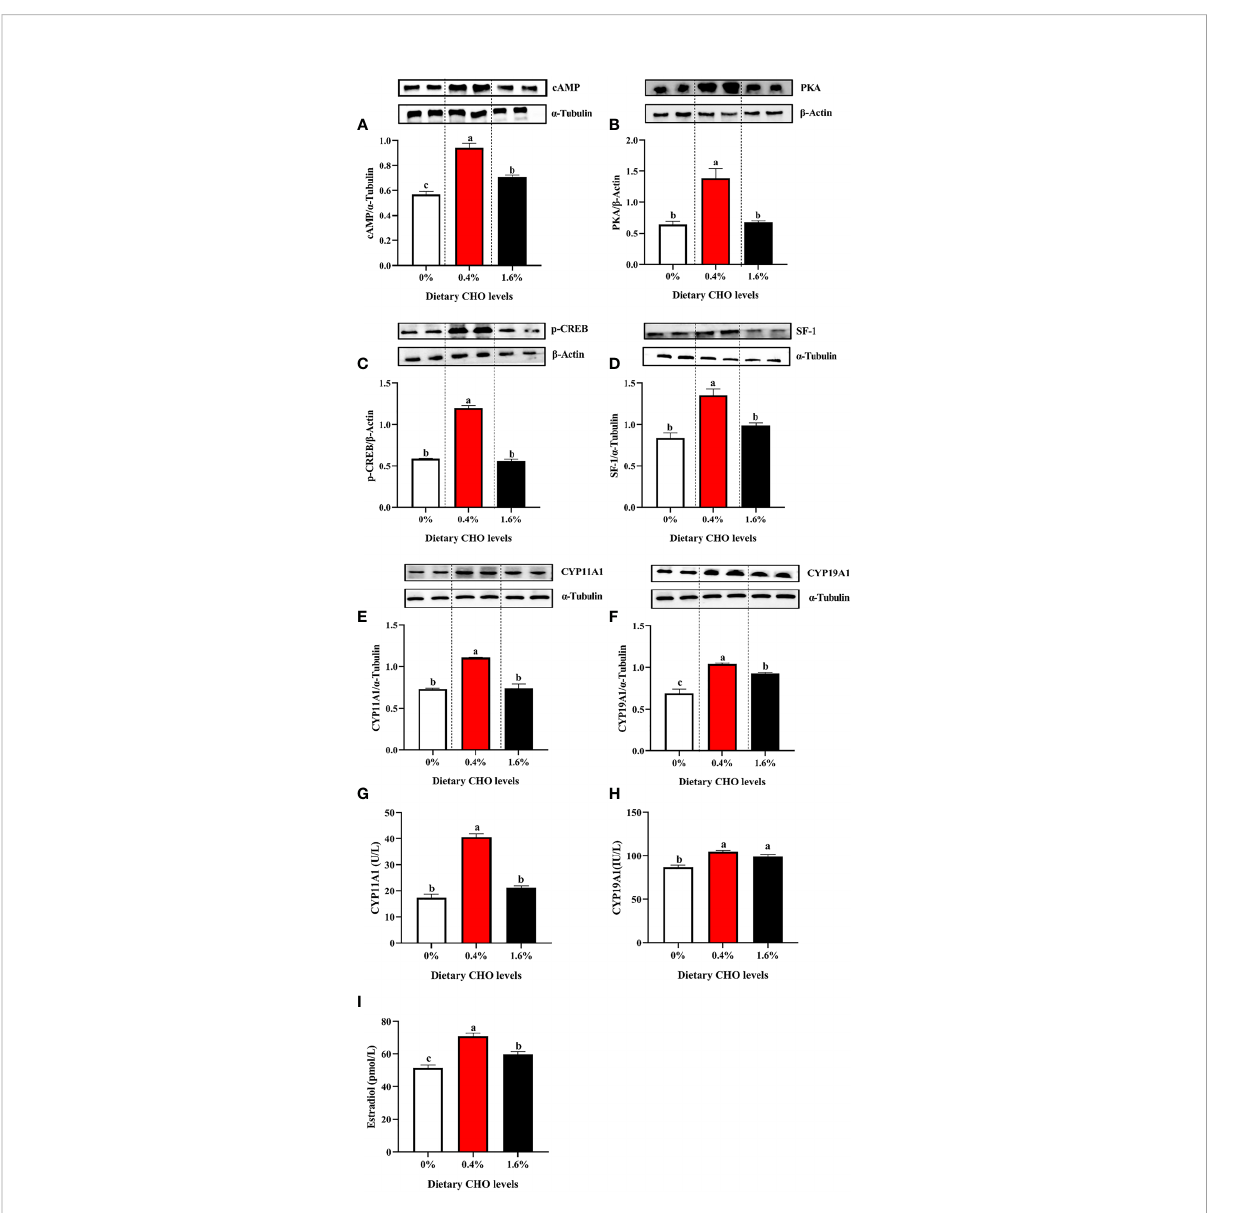
FIGURE 6 The protein expression of (A) cAMP; (B) PKA, (C) p-CREB, (D) SF-1, (E) CYP11A1 and (F) CYP19A1 in the ovary of Eriocheir sinensis fed with the experimental diets. (G) The activity of CYP11A1 in the ovary; (H) the activity of CYP19A1 in ovary; (I) the content of E 2 in ovary. The values are the Means ± SEM ( n = 4). Different letters indicate signi fi cant differences ( P <